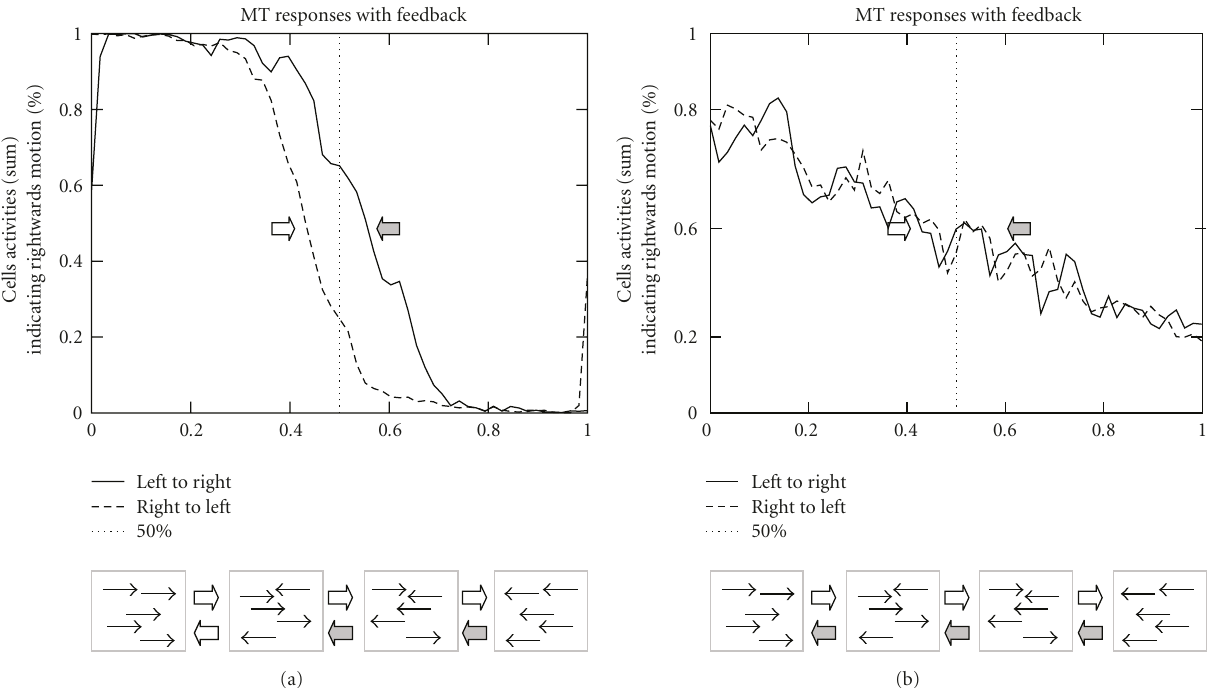
Figure 7: This example demonstrates the inertia of the dynamic feedforward and feedback interaction causing a perceptual hysteresis e ff ect. The proportion of MT cell activities indicating rightward motion ( Σ activities right / Σ activities left ) is plotted for each frame, processing two random dot kinematograms (the sequence shows 60 moving dots and consists of 60 frames with 40 × 40 px/frame). Random dots are initialized at random positions and a horizontal velocity of 3px/frame. All dots are initially moving in the same direction (in the first sequence (solid line) dots have rightward motion; in the second sequence (dashed line) dots have leftward motion). In each frame of a sequence one moving dot switches from the initial direction to now move in the opposite direction. Over time the percentage of dots still moving into the initial direction decreases linearly as the number of dots moving in the opposite direction increases in the same way. (a) Feedback processing disambiguates the signal and generates a directional hysteresis e ff ect that indicates the inertia generated by locking in the prediction from top-down feedback of a motion direction measured over time. Initially estimated motion is slightly ambiguous (80% correct and 20% incorrect motion) since the correlation detectors confound local dot correspondences. This uncertainty is resolved after few iterations by model MT cells such that coherent motion is signaled. The response for the sequence that started with 60 dots moving to the right (solid line) switches the sensed motion from dominant rightward to leftward motion when 60% up to 75% of the dots have switched their initial motion direction. Thus the network responses still keep their represented motion activity beyond the condition when half of the dots move in opposite directions (in our case 30 dots moving to the right and 30 dots moving to the left). This behavior is influenced by the history of previous activities since shifting the point of perceptual decision depends on whether the sequence started with 100% rightward motion or 100% leftward motion (hysteresis). (b) Without feedback, no hysteresis is generated. The sum of cell activities indicating rightward motion is proportional to the relative number of dots moving to the right (solid line). The initial ambiguity of 80% correct and 20% incorrect motion is not resolved. With each frame when more and more incoherence occurs due to the dots that switch their motion direction, the estimated motion responses linearly reduce their response amplitude. This behavior is symmetric for both test cases starting with coherent dot motion to the right or to the left, respectively. As predicted in this case when half of the dots move in opposite directions, the motion signal reduced to 50% of the maximum. The figure is reprinted with permission from Bayerl and Neumann